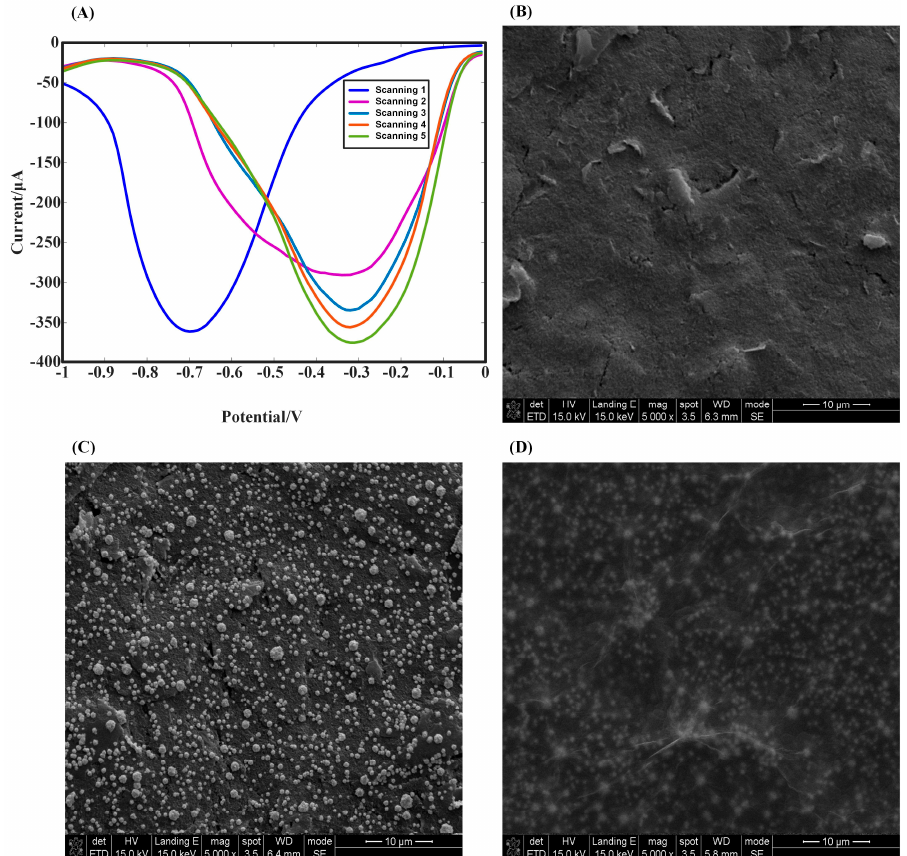
Figure 2. Characterization of the SPE/AuNPs/GO - COOH aptamer’s sensing interface. ( A ) Electrodeposition of AuNPs using the SWV method with five scans. ( B ) SEM electron micrograph of the bare electrode. ( C ) SEM characterization of the electrode surface after the electrodeposition of AuNPs. ( D ) Surface characterization of the GO - COOH physically adsorbed on an electrode containing AuNPs.